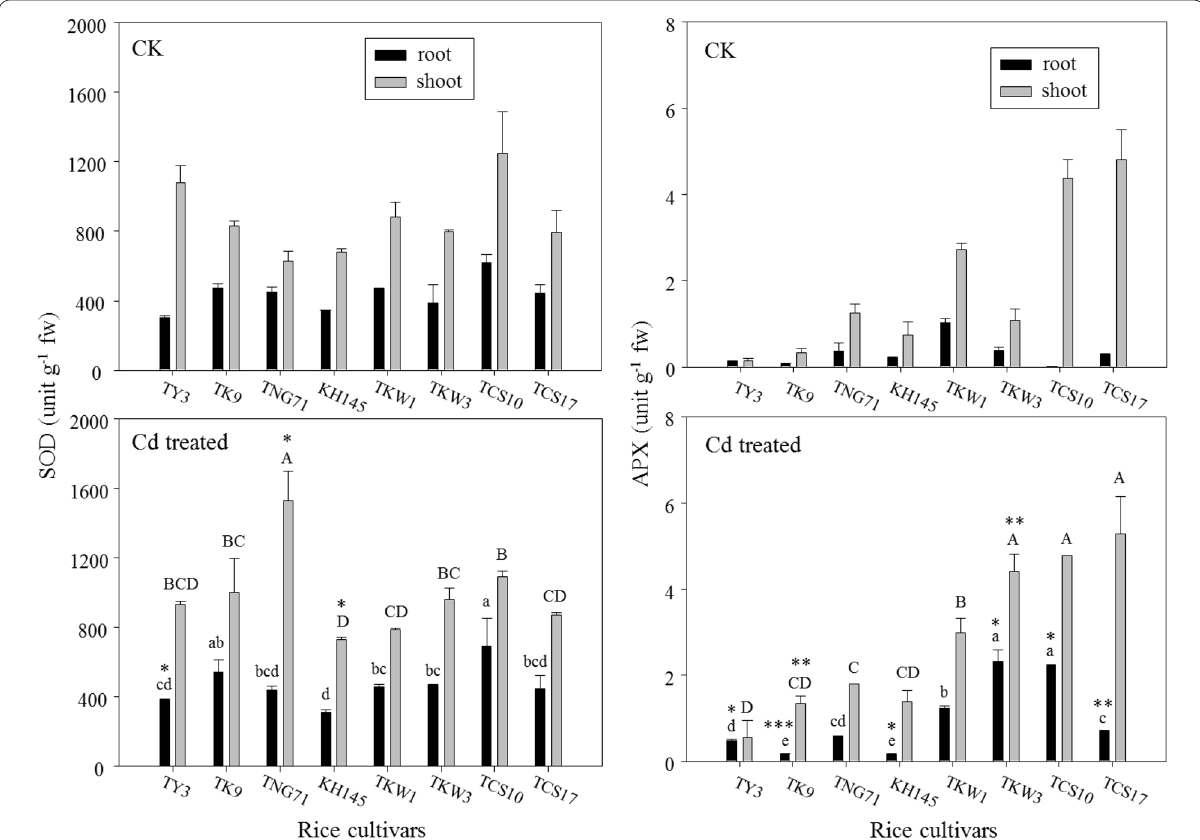
Fig. 4 Activities of superoxide dismutase (SOD) and ascorbate peroxidase (APX) in root and shoot for the rice seedlings after a 7‑day exposure of 50 μM Cd (Cd treated) and a check (CK) of the cultivars, TY3, TK9, TNG71, KH145, TKW1, TKW3, TCS10, and TCS17. Error bars represent the standard errors of the mean values (replicates n 3). Same lowercase letters above the black bars and same capital letters above the gray bars indicate the = mean values are not significantly different at p < 0.05 among the cultivars according to the last significant difference (LSD). *, **, and *** indicate significant differences at p < 0.05, p < 0.01, and p < 0.001 between Cd treated and CK by the